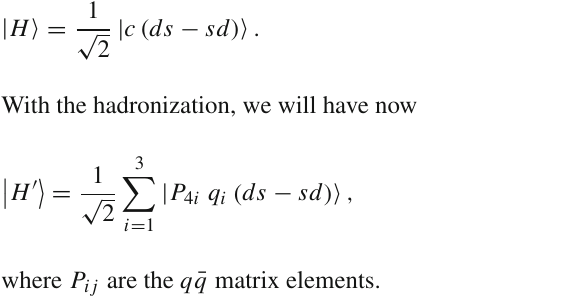
Fig. 1 Diagrammatic representation of the weak decay (cid:2) −